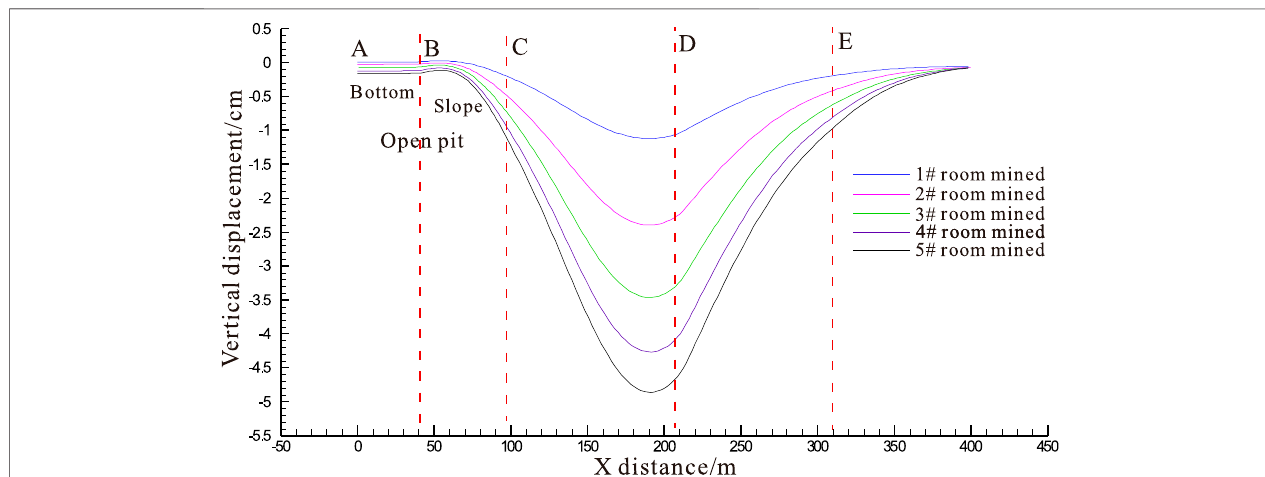
FIGURE 13 | Vertical displacement curves of the surface when mining Rooms 1# to 5#.